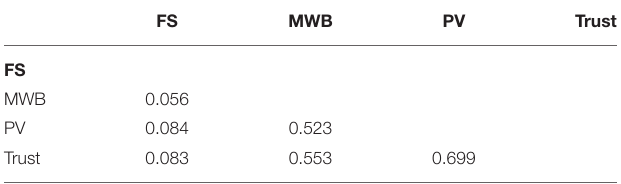
TABLE 3 | Discriminant validity (HTMT ratio).